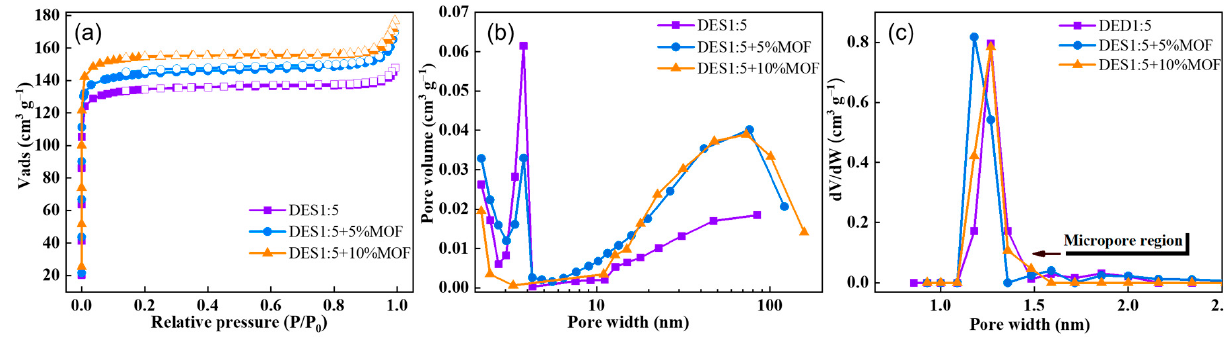
Figure 4. N 2 adsorption–desorption isotherms ( a ) and PSDs ( b , c ) of the LRF carbon cryogels.